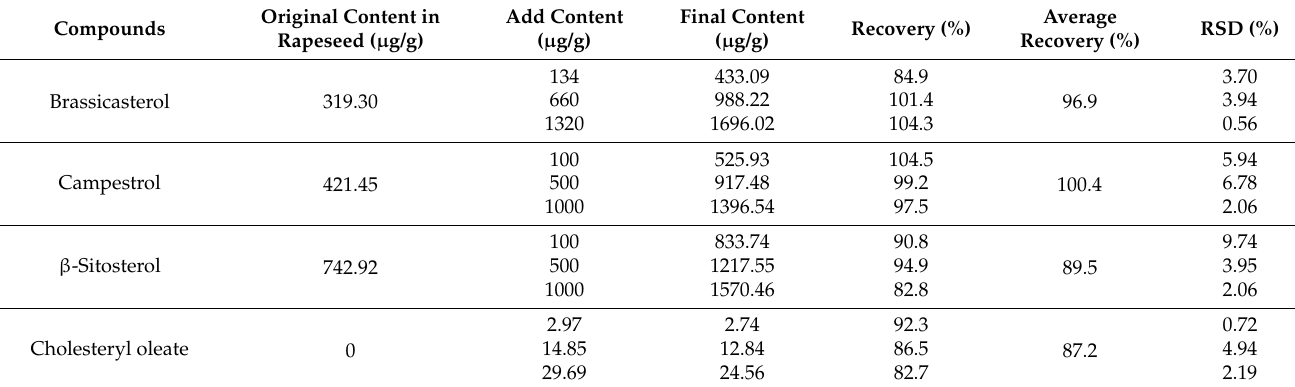
Table 1. Recovery of phytosterols in